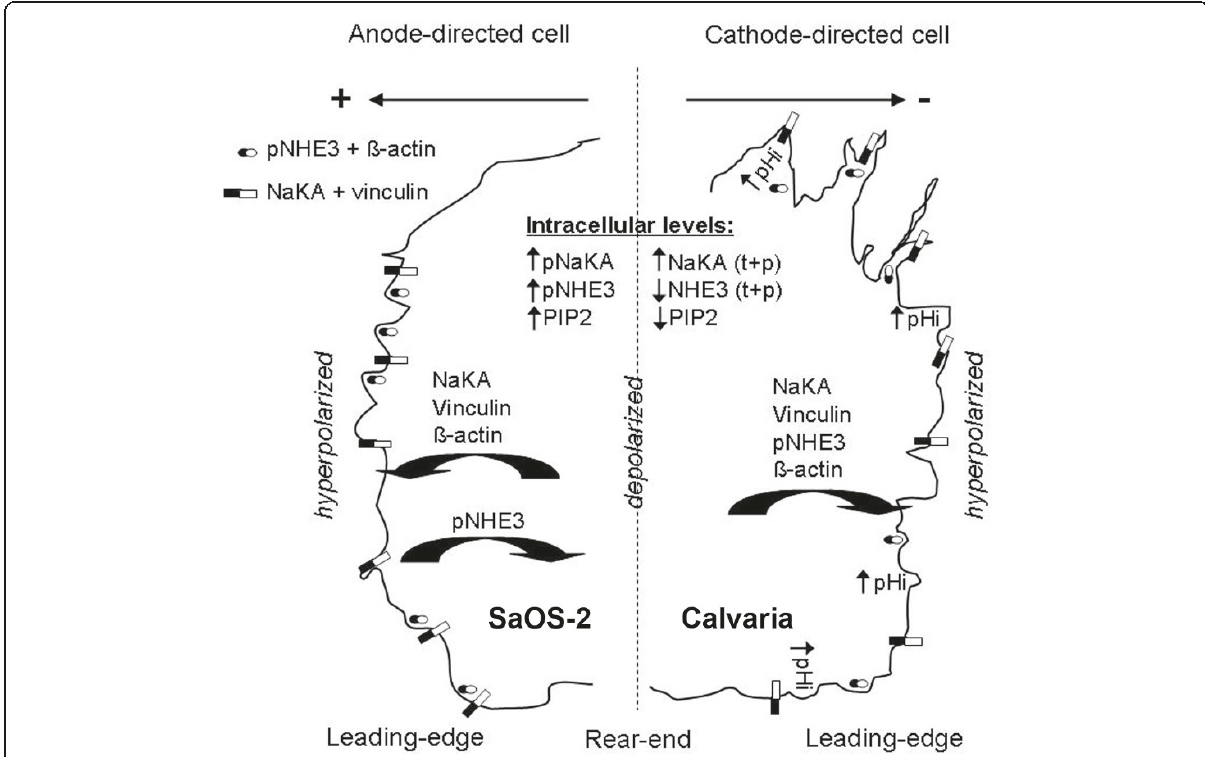
Figure 7 A schematic of NaKA and NHE3 activity on the leading edge of cathode (Calvaria)- or anode (SaOS-2)-directed cells during electrotaxis . Cells are polarized with a well-defined front and back during electrotaxis. Independent from the migration direction, NaKA is relocated from the cytoplasm to the protrusions, wherein its enhanced activity on the leading edges of cells and results in a hyperpolarized cell membrane, whereas the rear end membrane remains depolarized. Active NHE3 and consistently elevated pHi levels appear to be preferentially localized to the protrusions at the leading edges of cathode-directed cells, but not in anode-directed cells, which indicates a cathode-specific directional sensing. At the mechanical level, the colocalization of NaKA with vinculin at focal adhesion sites and the colocalization of active NHE3 with the filopodia marker ß-actin suggest a direct action for NaKA and for NHE3 in adhesion turnover and in filopodia formation,